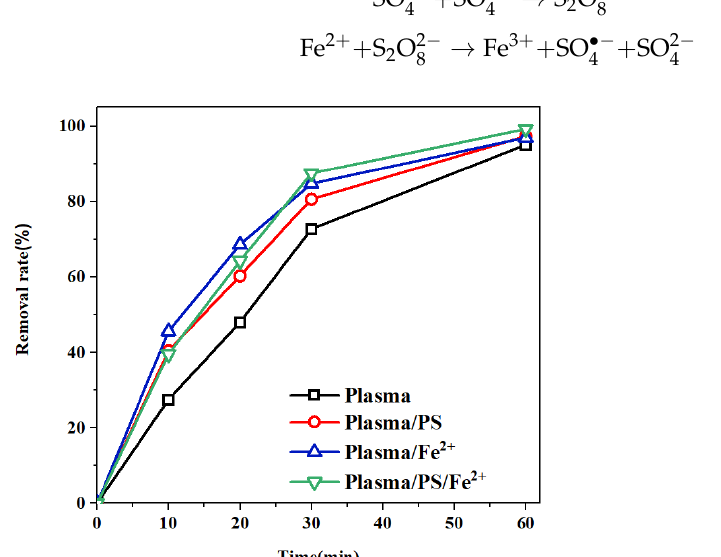
Figure 8. The removal rates of MO under plasma, plasma/PS, plasma/Fe 2+ and plasma/PS/Fe 2+ sys ‐